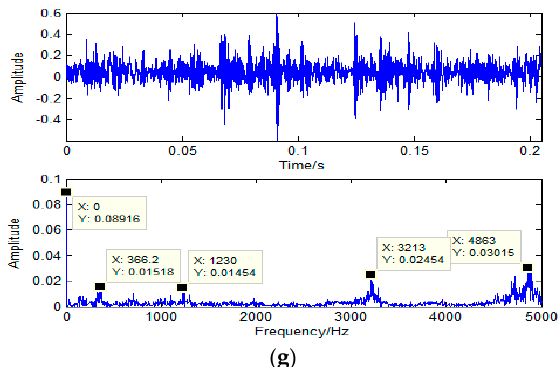
Figure 23. Time domain waveform and spectrogram of different health conditions in Experiment 2.